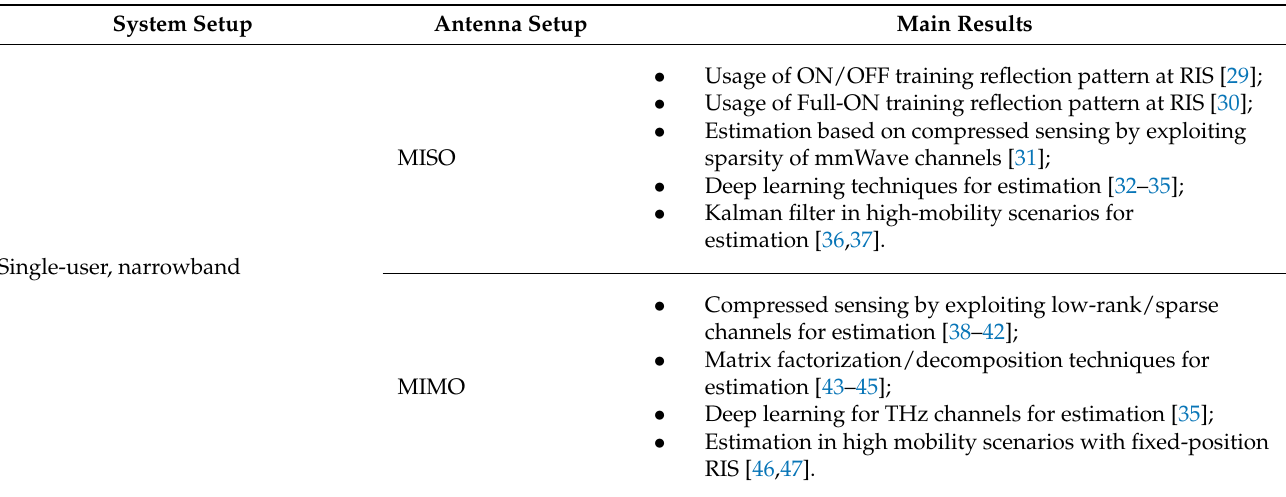
Table 1. RIS channel estimation for different system setups